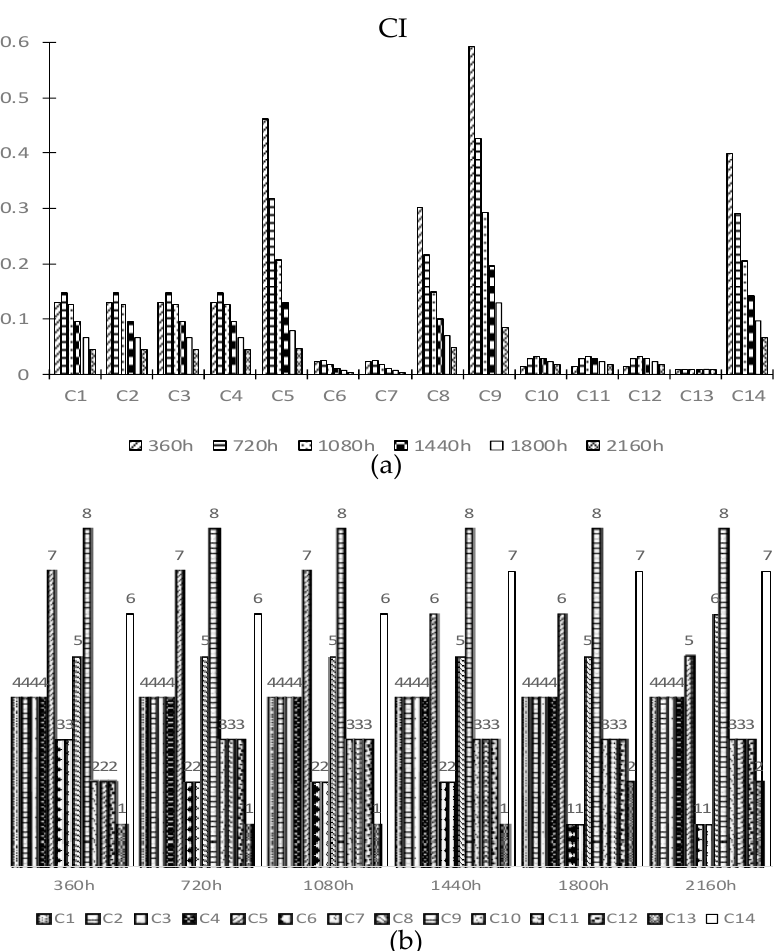
Figure 10. CI values ( a ) and ranking bar charts ( b ) of the 14-component system when P N is less than P out .